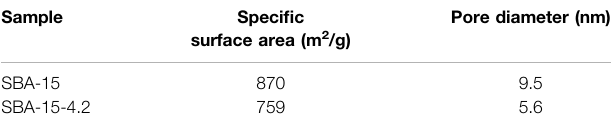
TABLE 1 | Structure information of the two types of